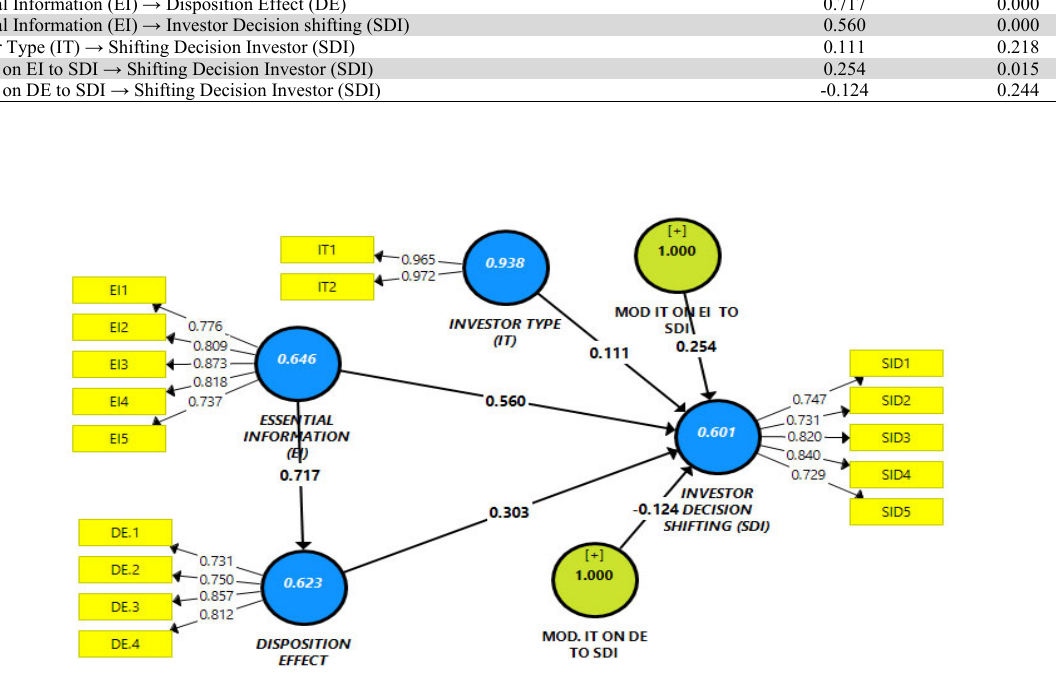
Fig. 1. Research model for analysis